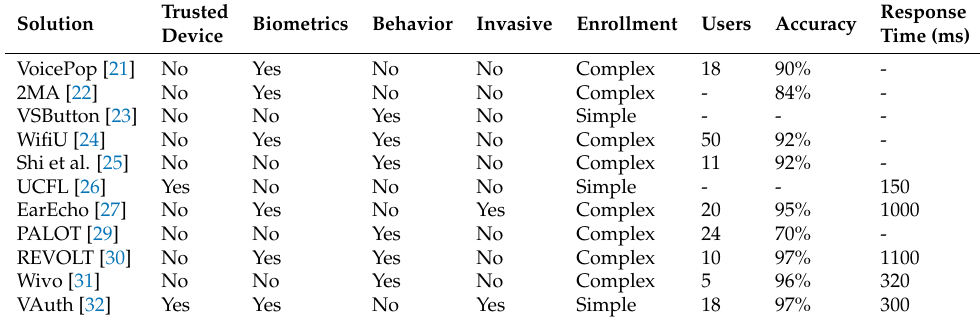
Table 1. Related work